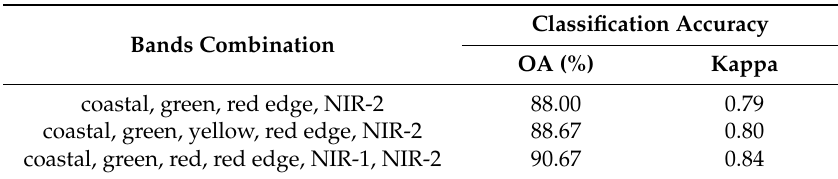
Table 2. Maximum Likelihood Classification accuracies for mapping spatial distribution of seagrass using different spectral combinations. OA is the Overall